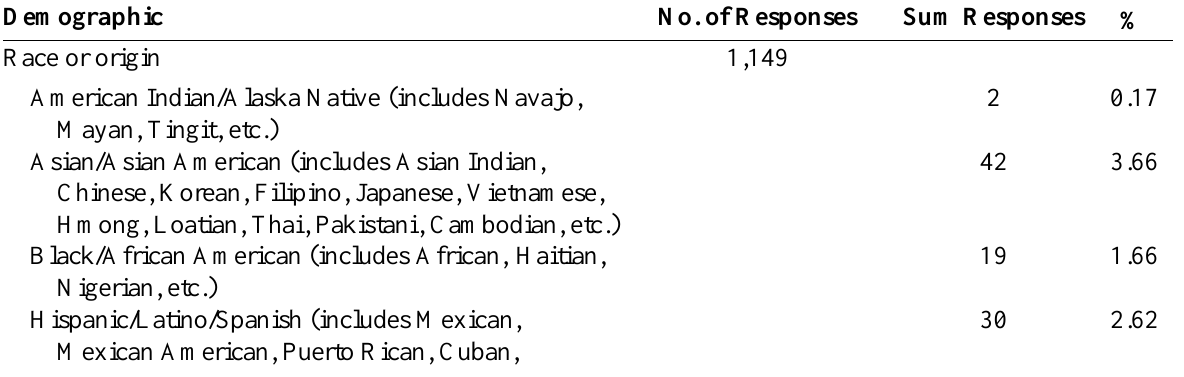
Race or Origin of Survey Respondents Demographic No. of